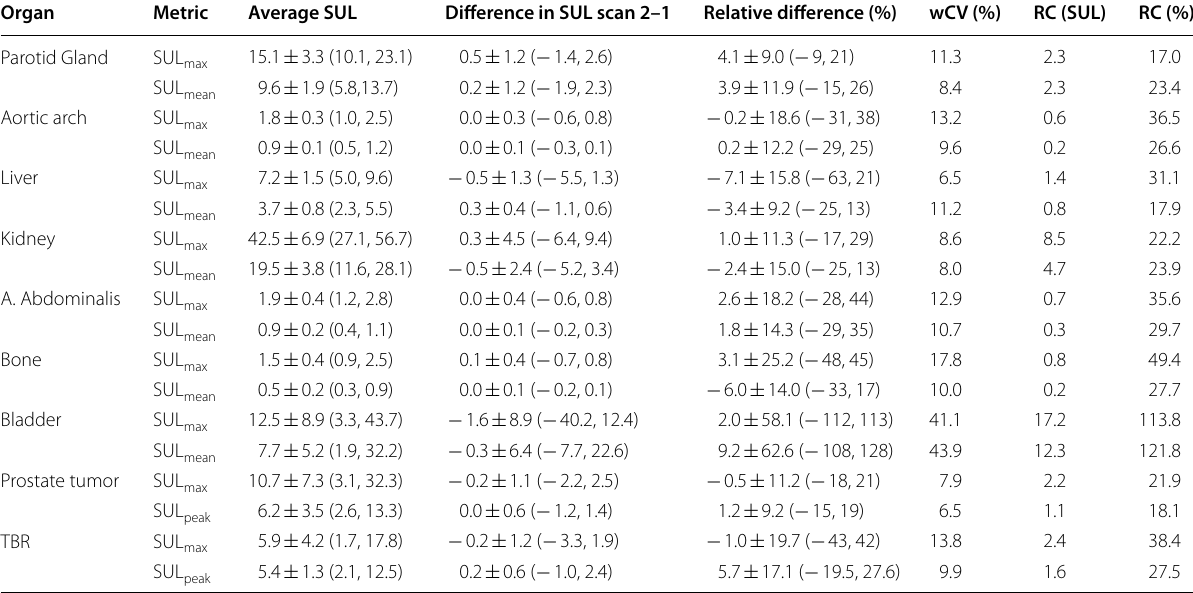
Values are displayed as mean standard deviation (min, max). Average SUL of each site was calculated as mean over all subjects and all scans. Difference SUL and the ± relative difference are calculated as the group average of the difference